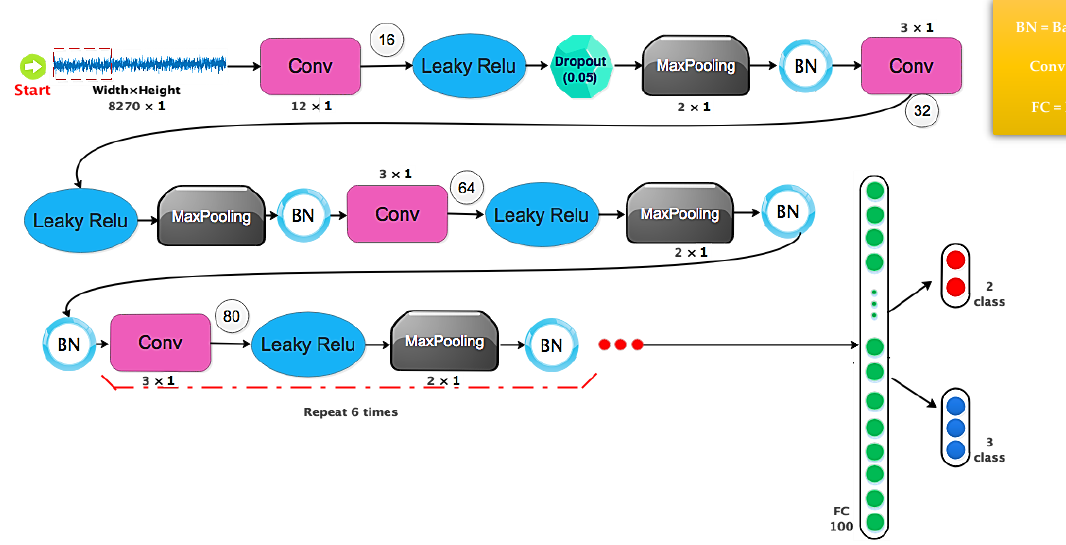
Figure 5. Proposed network architecture.